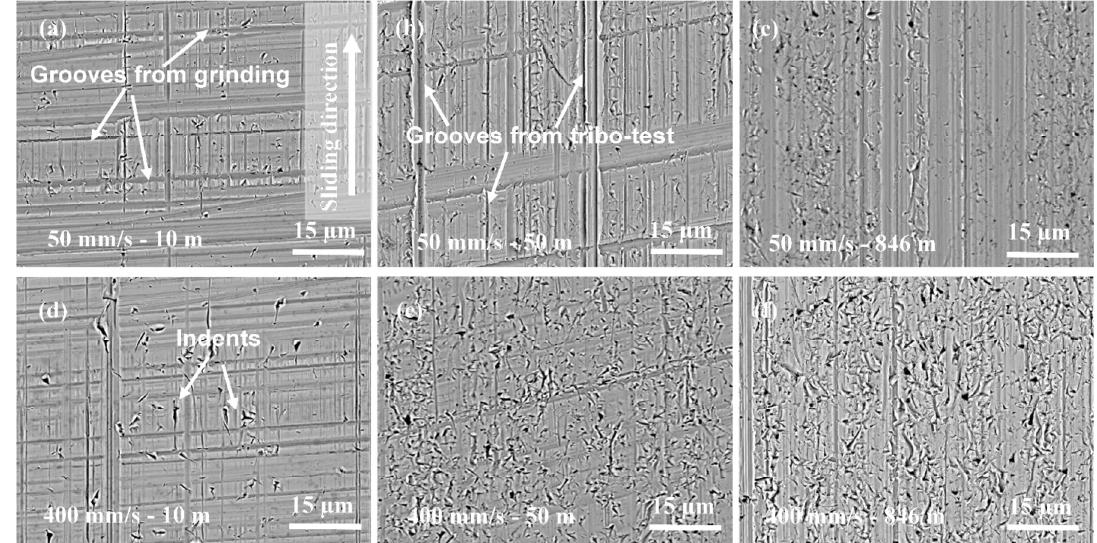
Fig. 6 SEM images of discs after constant speed experiments: (a) sliding 10 m at 50 mm/s; (b) sliding 50 m at 50 mm/s; (c) sliding 846 m at 50 mm/s; (d) sliding 10 m at 400 mm/s; (e) sliding 50 m at 400 mm/s; and (f) sliding 846 m at 400